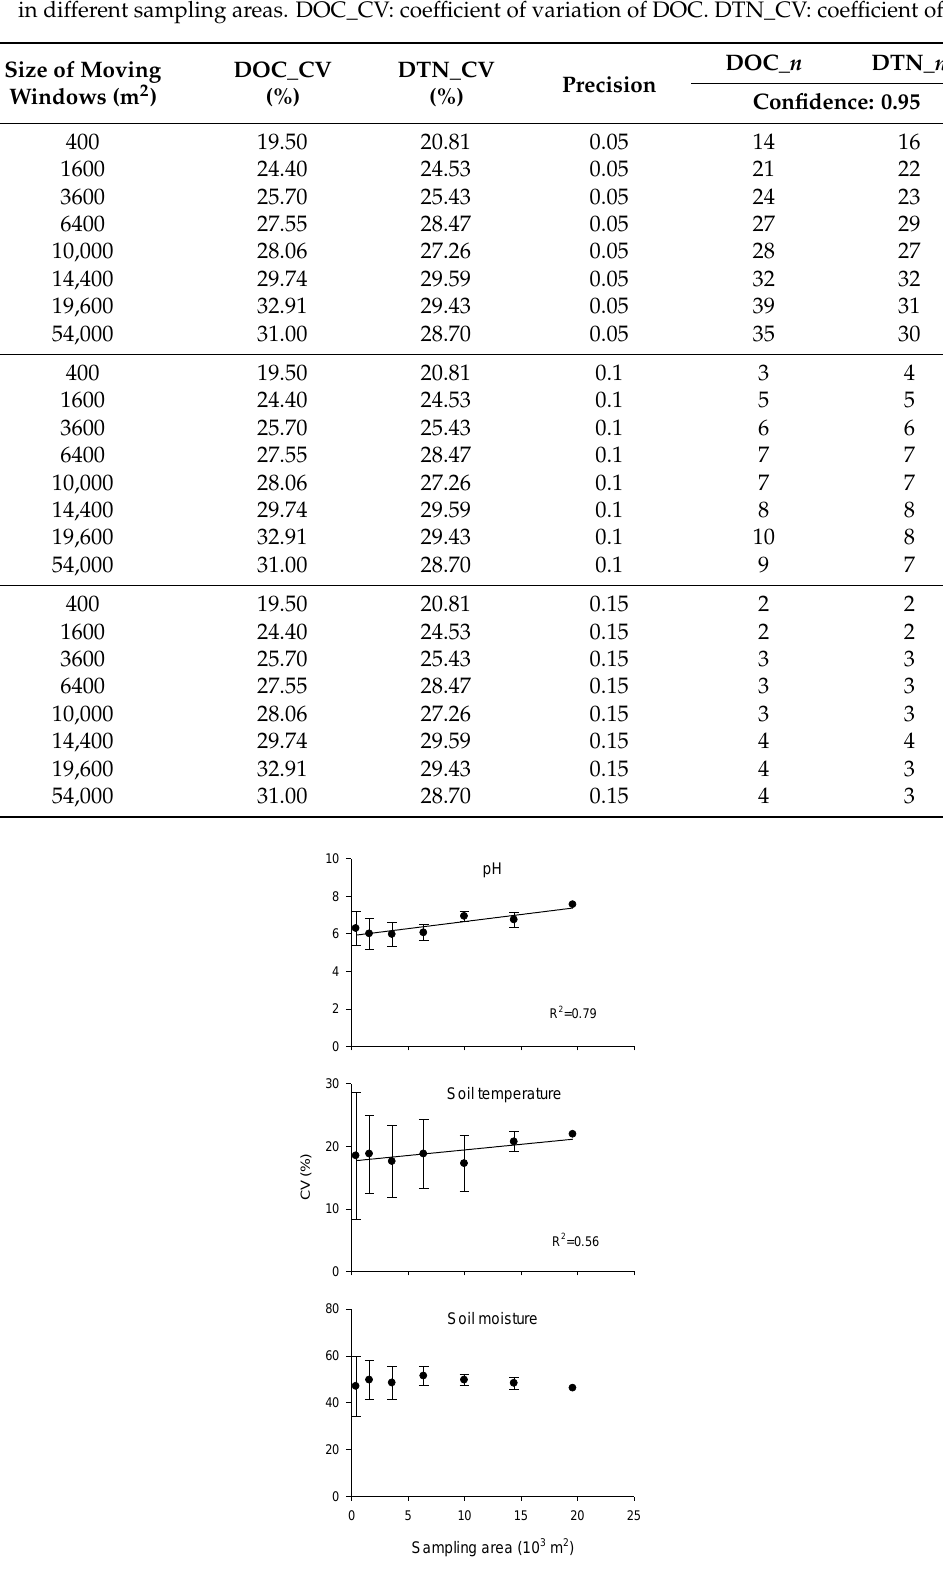
Table A1. Sample numbers ( n ) of DOC (DOC_ n ) and DTN (DTN_ n ) required for their estimation at a given accuracy level